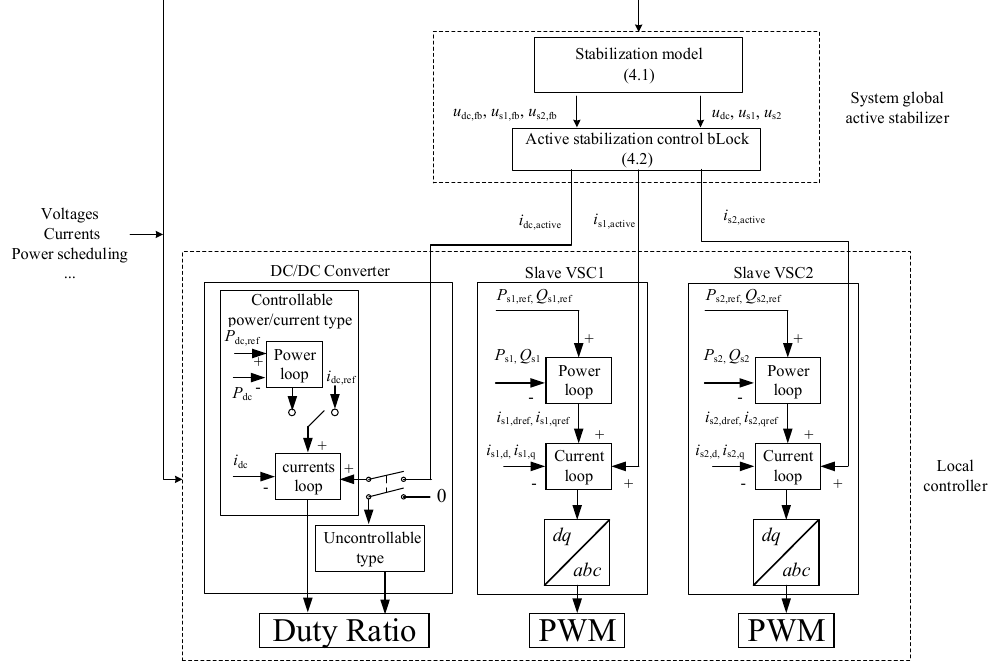
Figure 6. Active stabilization control scheme of the LV multi-terminal AC/DC hybrid system.